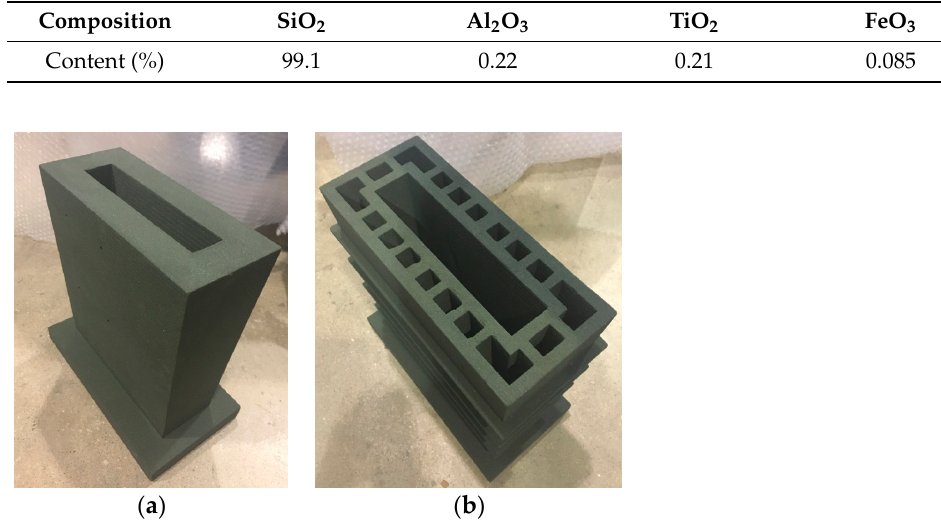
Figure 6. Sand mold fabricated by 3D printing: ( a ) traditional dense sand mold and ( b ) hollow sand mold with chimneys.